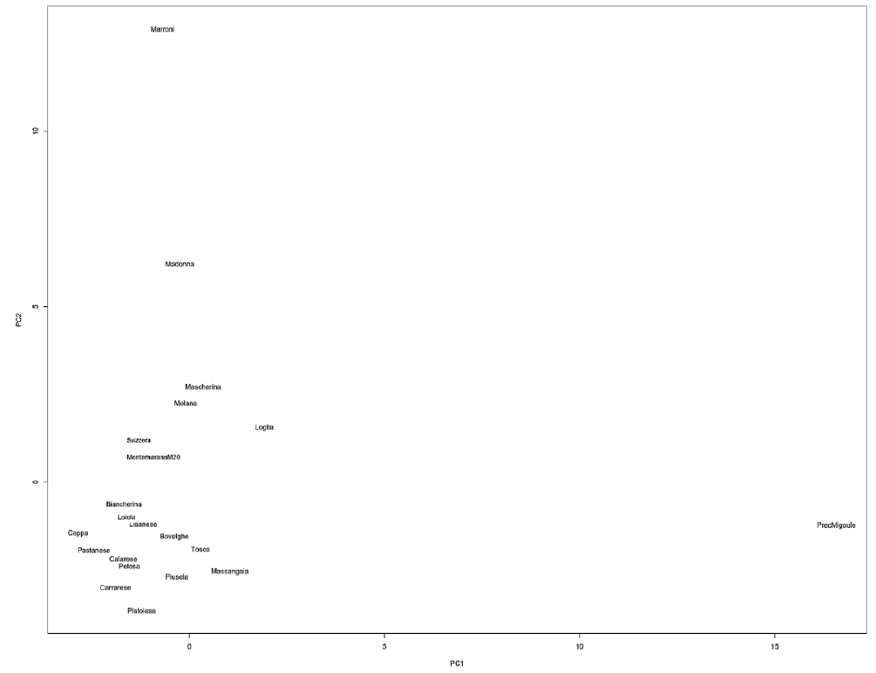
Figure 2. Principal Coordinate Analysis (PCoA) of the 21 chestnut unique genotypes based on the 16 SSR data. The first component (PC1) explains 15% of the variation and the second component (PC2) 11%.